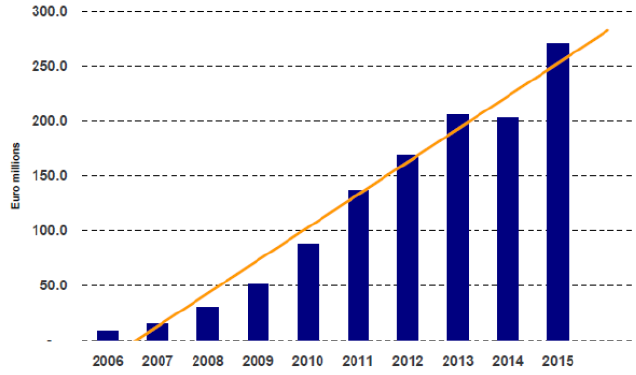
Figure 1. Total market for civil and commercial UAS markets in Europe (Frost &